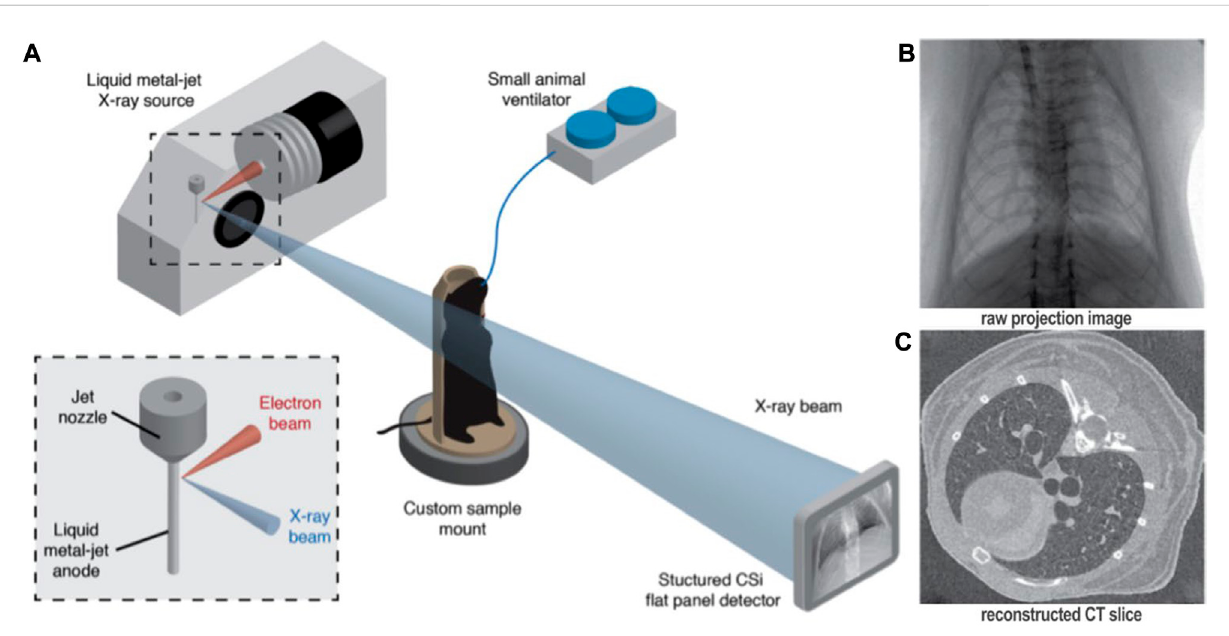
FIGURE 8 Four-dimensional x-ray velocimetry (4DxV) technique for regional lung function assessments [reprinted from Murrie et al. (2020)]: (A) Experimental image acquisition setup using a liquid-metal-jet microfocus X-ray source, introduced by Murrie et al. (2020) for in vivo regional lung function measurements; (B) Raw 2D projections acquired over 360 ° using the proposed image acquisition setup; (C) Reconstructed CT images from the binned projections to produce 4D CT